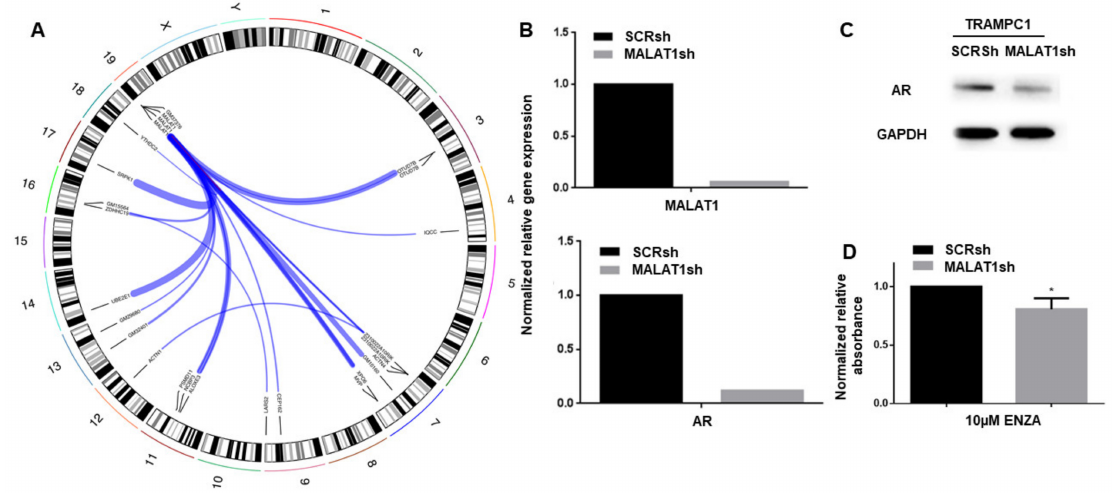
Figure 4. MALAT1-fusions are abundant and regulate resistance towards androgen receptor inhi- bition in TRAMP tumor cells. ( A ) Circos plot showing the most frequently detected gene fusions found in 12 organoid lines derived from three individual TRAMP tumors as well as the TRAMPC1 cell line ( n = 13 samples; raw data provided in Supplementary File S1). ( B ) Lentiviral knockdown